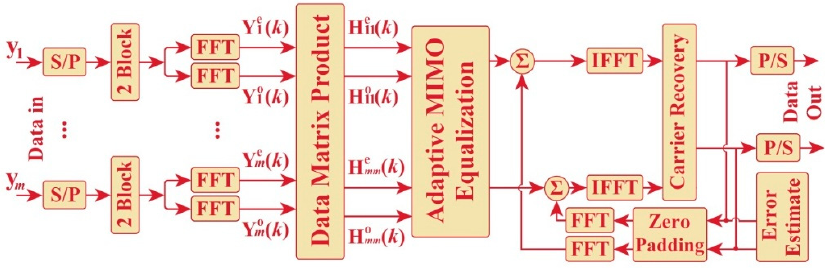
Figure 7. The space and time allocation for the space–time block-coding (STBC)-aided recursive least squares (RLS) algorithm [31].